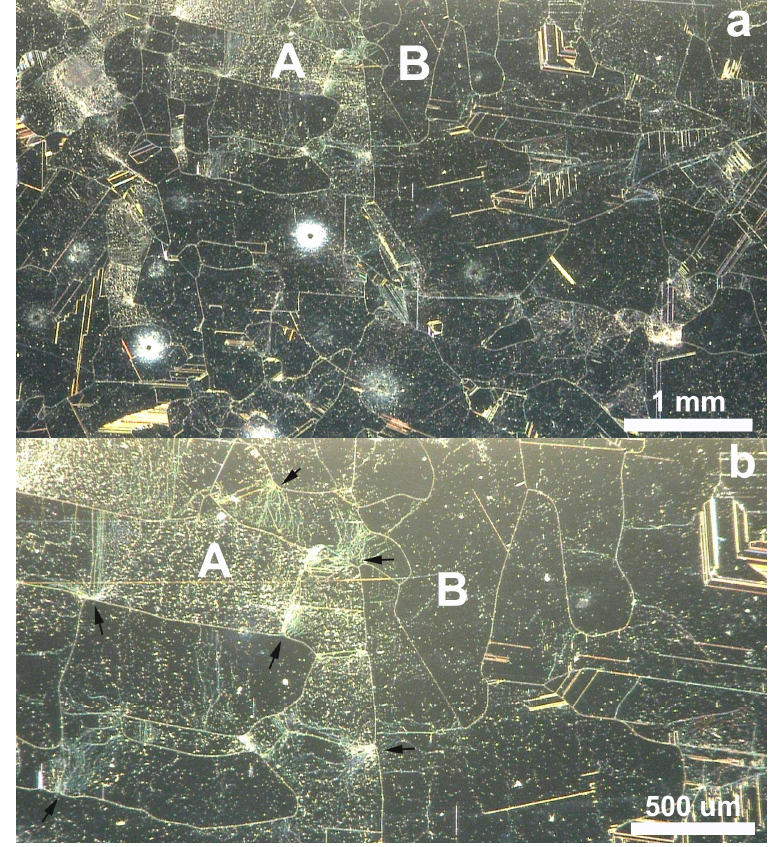
Figure 2. Optical microscopy images of the minicrystallized region with relatively low ( a ) and high ( b ) magnification. The bar length is 1 mm for (a) and 500 μ m for (b).